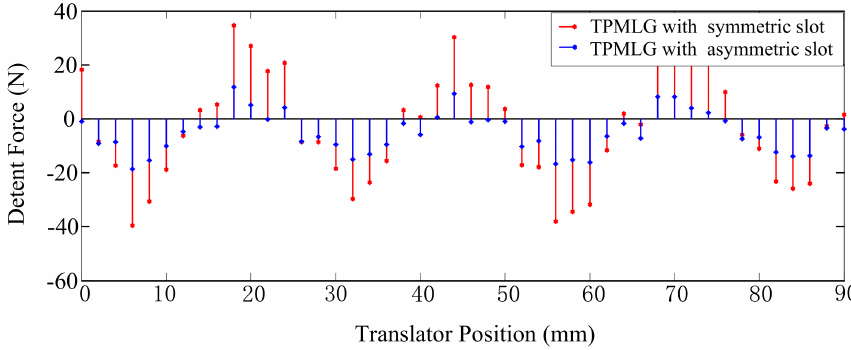
Figure 10. Detent force of the TPMLGs with asymmetric and symmetric slots.